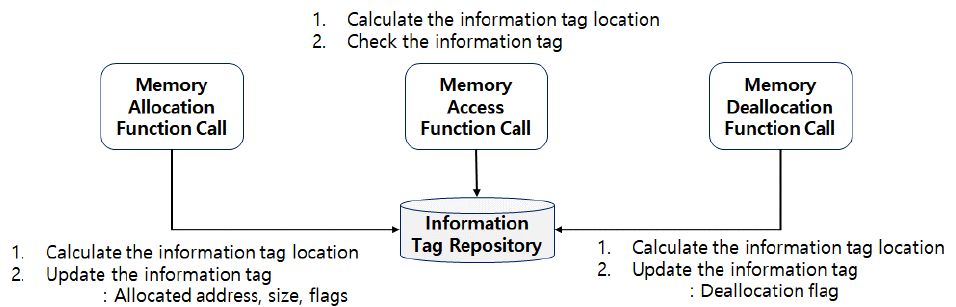
Figure 4. Management of information tag.